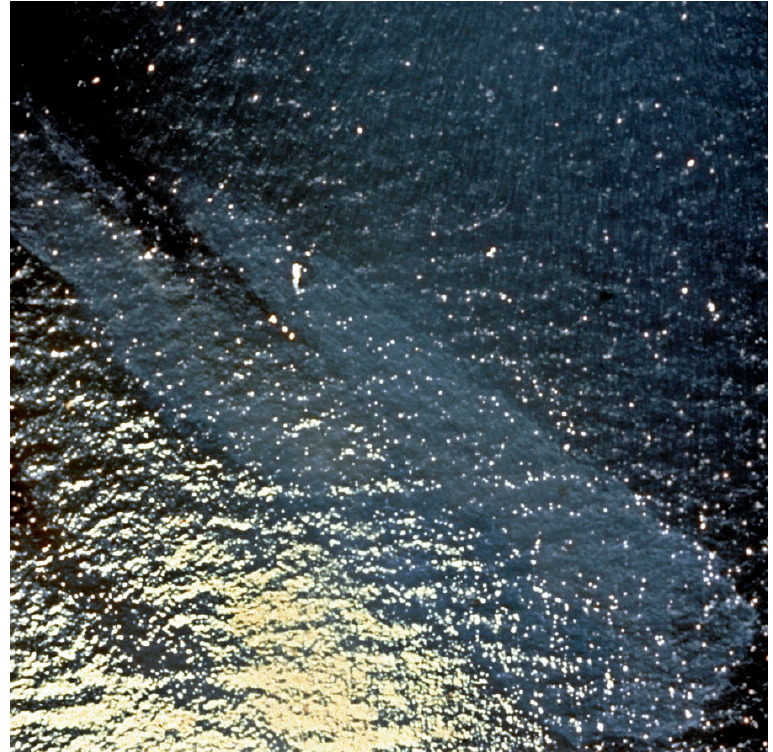
Figure 3. A visible photo of a small test slick. The sun glint on the left confounds the interpretation of slick edges (photo from Environment Canada).